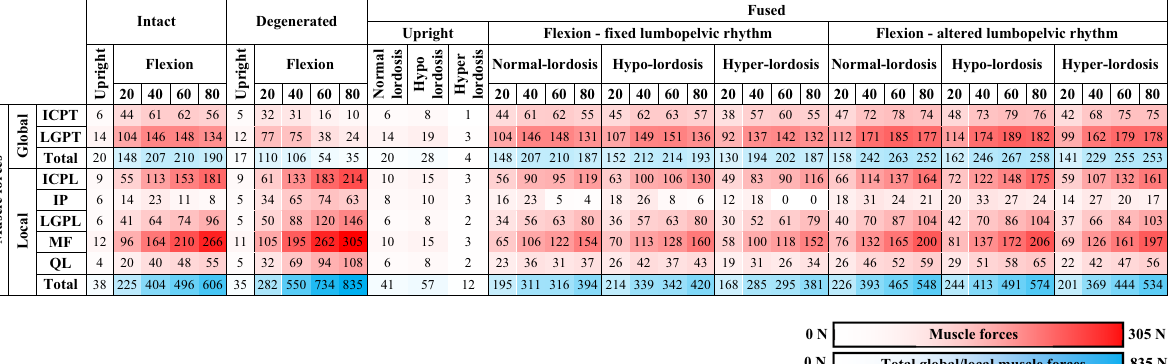
Table 2. Unilateral forces (N) in local muscles (ICPL: iliocostalis lumborum pars lumborum, LGPL: longissimus thoracis pars lumborum, IP: iliopsoas, MF: multifidus; QL: quadratus lumborum) and global muscles (ICPT: iliocostalis lumborum pars thoracis, LGPT: longissimus thoracis pars thoracis) as well as the sum of local and global muscle forces. No forces in abdominal muscles (IO: internal oblique; EO: external oblique; RA: rectus abdominus) were computed in all simulated tasks. Please note the legends at the bottom for the color